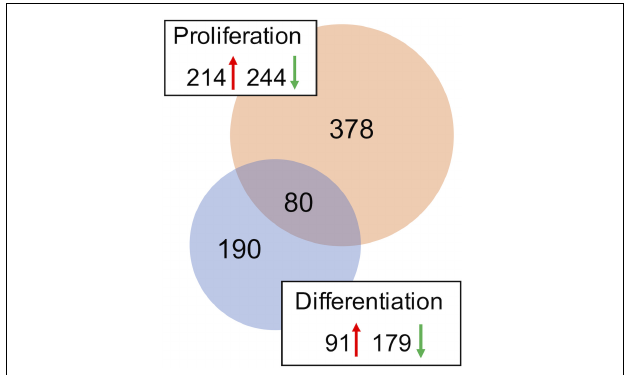
FIGURE 2 | Distribution of differentially expressed genes in the turkey satellite cells. For each comparison, the number of significant genes (FDR p -value < 0.05) shared or unique to each treatment are indicated in the Venn diagram. Circle size is proportional to the number of genes and direction of expression change ( ↑ or ↓ ) is given for each group.